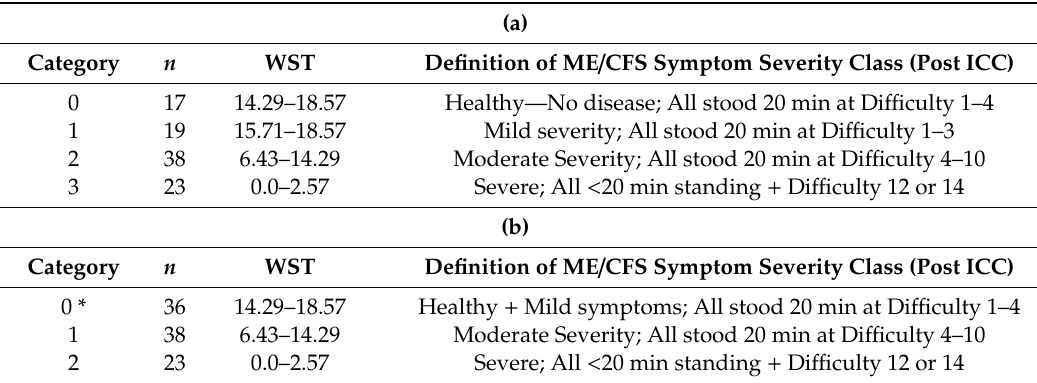
Table 1. With the majority of the study participants able to stand for the entire 20 min of the orthostatic intolerance (OI) test, standing time alone was not an e ff ective response variable. Table 1. Definitions of ME / CFS symptom severity classes by Weighted Standing Time (WST), with reference to standing time and di ffi culty. ( a ) Four categories featuring a healthy control category, and a severity scale from mild to severe symptoms. ( b ) Three severity classes where the healthy control cohort (0) was combined with the mild category (1) from Table ( a ) to increase sample size for random forest algorithm interrogation (WST). All ME / CFS cases fulfilled the ICC diagnostic